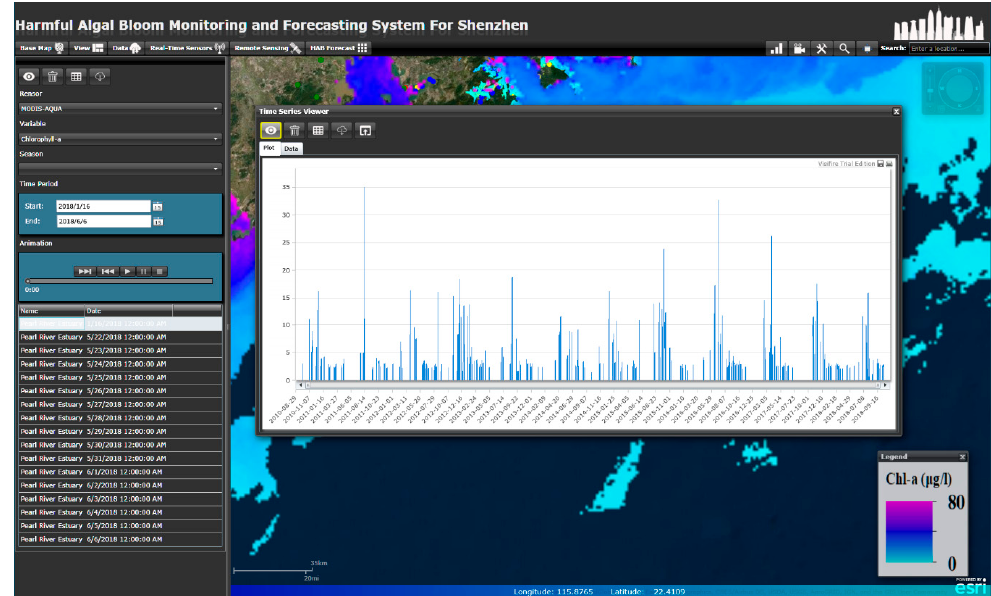
Figure 7. Time series of chlorophyll (Chl-a) concentration from MODIS-Aqua products at a location in the Shenzhen Bay.